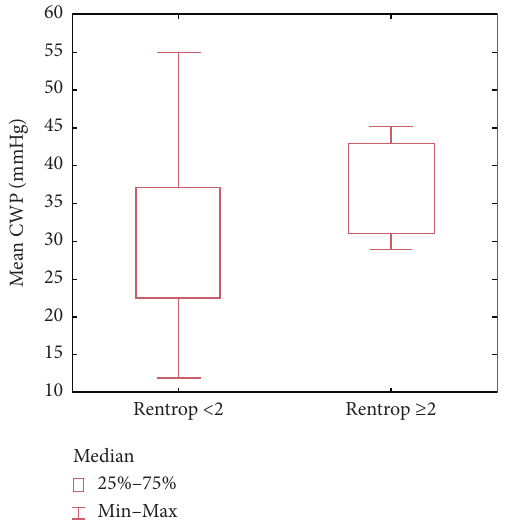
Figure 3: The association between mean CWP and Rentrop collateralization grade. Mean CWP was significantly lower in patients with Rentrop collateralization grade < 2 ( p � 0 . 05 ) . CWP � coronary wedge